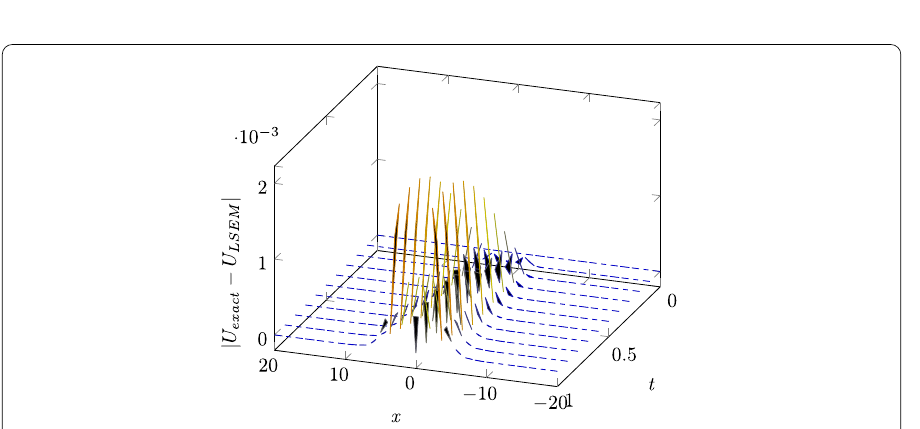
Figure 1 LSEM approximation for sine-Gordon equation for Example 5.1 with N = 4, N e = 20, and k = 0.1 for t ≤ 1